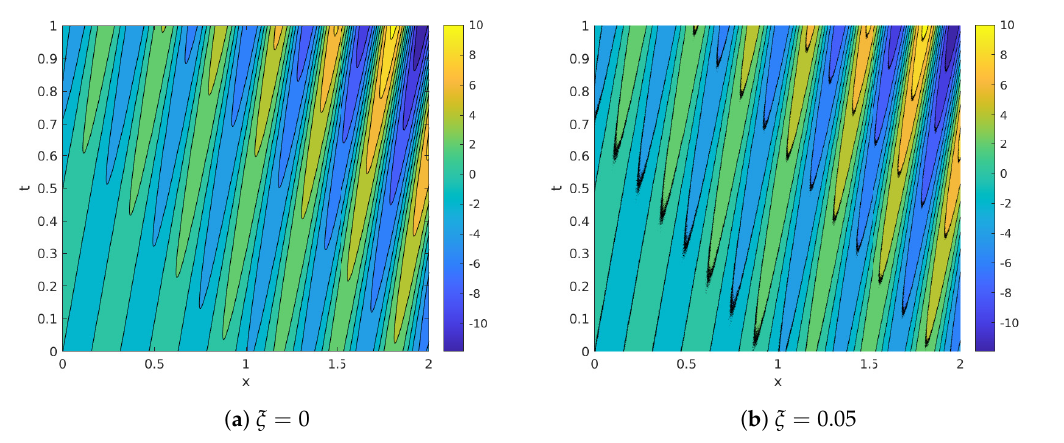
Figure 1. Synthetic system: clean ( a ) and noisy ( b ) fields.